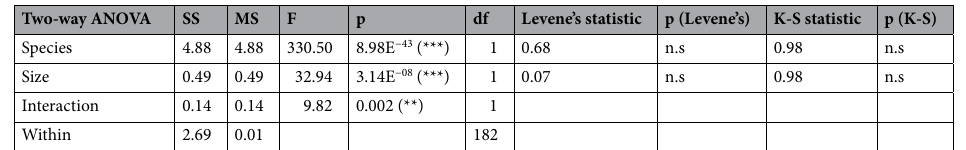
Table 2. Two-way ANOVAs, Levene’s statistic and Kolmogorov–Smirnov (K-S) statistic on somatic growth rate (SGR) of sea cucumbers, reared under a mussel farm, between species ( Holothuria tubulosa and Holothuria polii ), size (small and large) and their interaction [n.s: p > 0.05; *p < 0.05; **p < 0.01; ***p < 0.001]. SS sum of squares, MS mean squares, F F values, p p-values, df degrees of freedom.